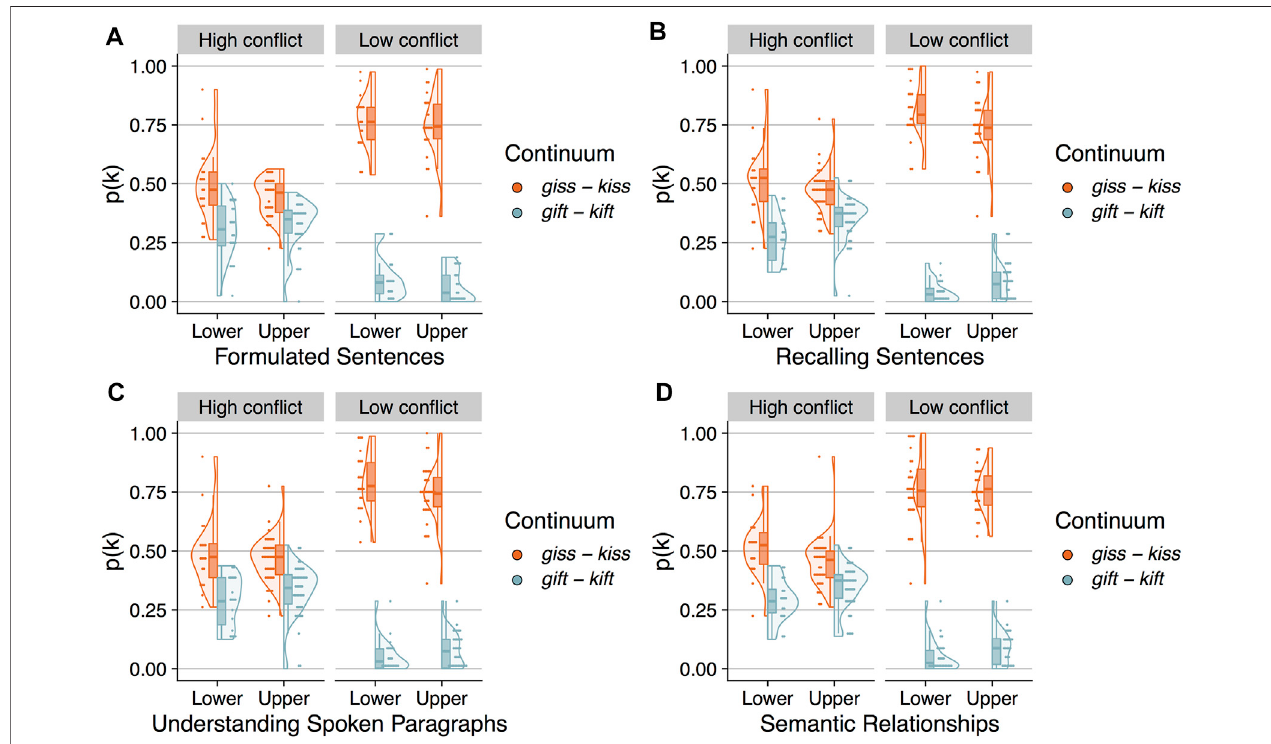
FIGURE 4 | Each panel shows the distribution of proportion /k/ responses for each continuum for listeners in the high con fl ict and low con fl ict conditions, grouped by performance (i.e., lower half vs. upper half) on a speci fi c CELF-5 subtest. As noted in the main text, this grouping is for visualization purposes only; performance on each subtest was entered into the analysis models as a continuous variable. Performance is split by Formulated Sentences in (A) , Recalling Sentences in (B) , Understanding Spoken Paragraphs in (C) , and Semantic Relationships in (D) .